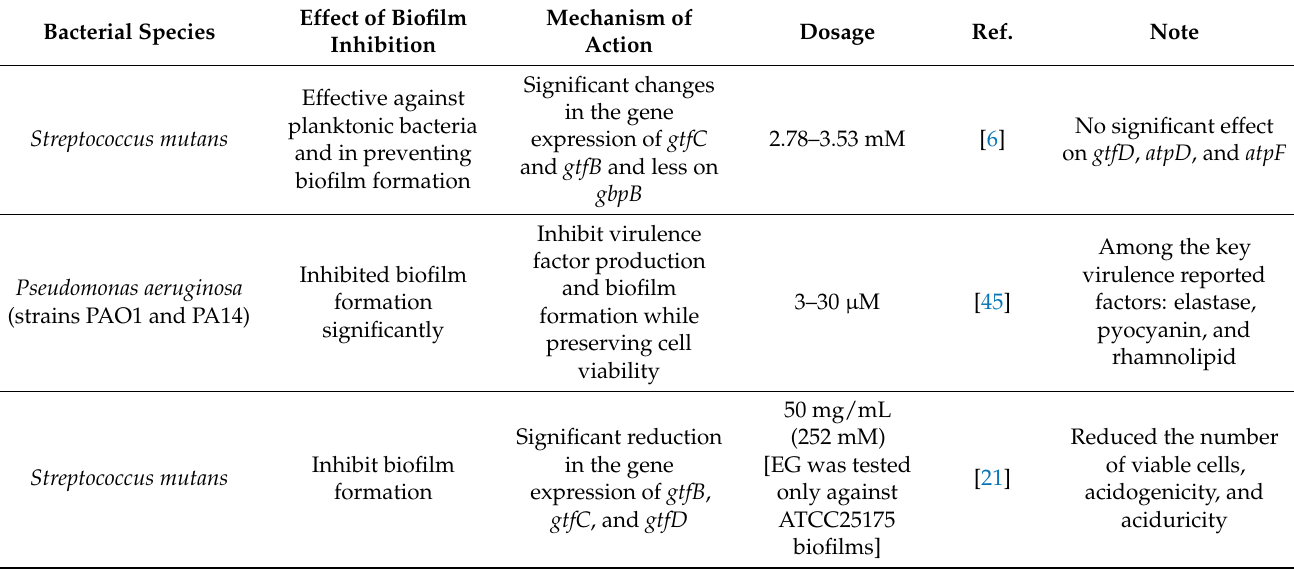
Table 3. Ethyl gallate inhibition of biofilm formation by several tested pathogens and suggested mechanisms of